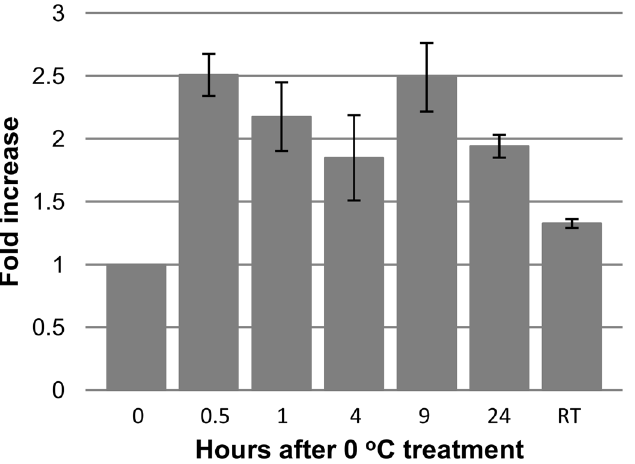
Fig 4. Expression profile of SspNIP2 in S . spontaneum TUS05-05 during 24 hrs of cold treatment. Time course experiment was conducted by qRT-PCR to study the dynamics of SspNIP2 gene expression profile during cold treatment. Five TUS05-05 plants were subjected to cold treatment at 0°C, and leaf tissue samples were collected at different time point as shown on the Fig for RNA preparation. RNA samples from five individual plants were pooled for qRT-PCR. qRT-PCR was conducted three times with triplicates each time. RT indicated the RNA sample prepared from plants that were returned to normal growth condition after cold